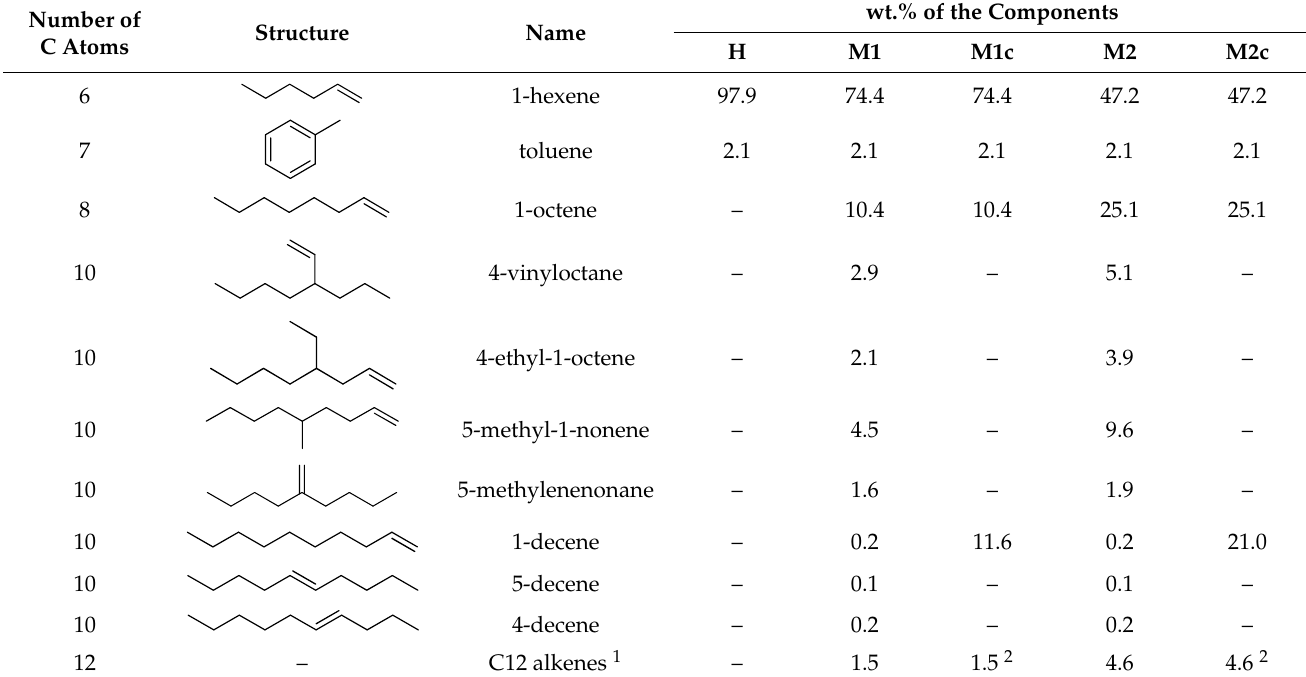
Table 1. Compositions of the oligomerization products, model linear α -olefin mixtures, and 1-hexene benchmark feedstock. Number of Structure C Atoms